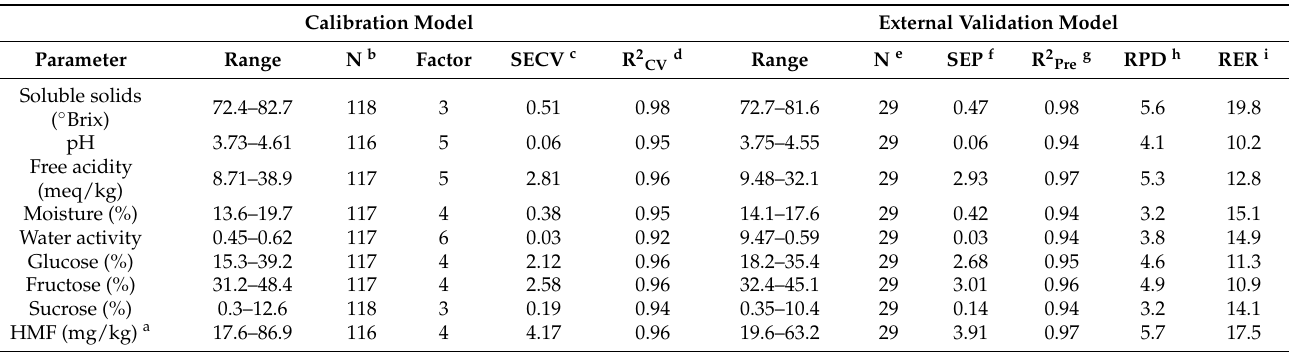
Table 2. Performance statistics of calibration and external validation models developed by using portable FT-IR